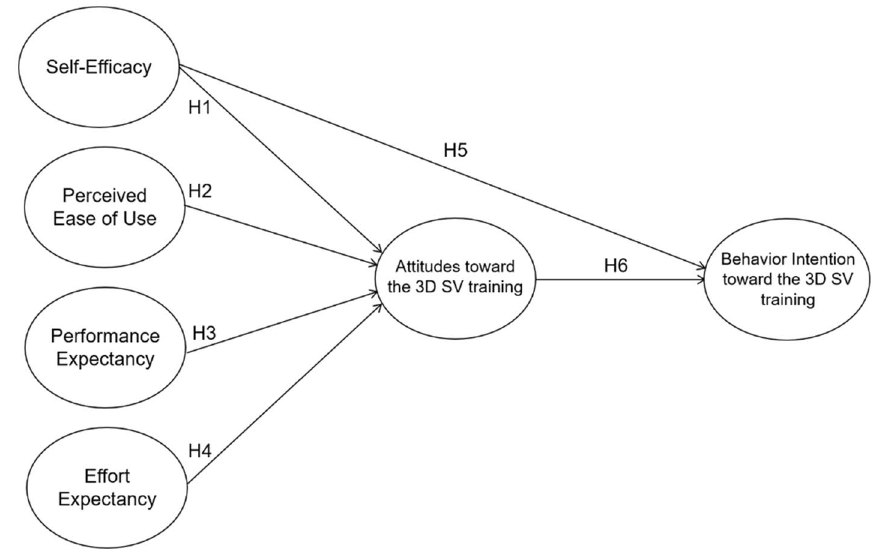
Fig. 1 Theoretical framework of this study. SV spatial